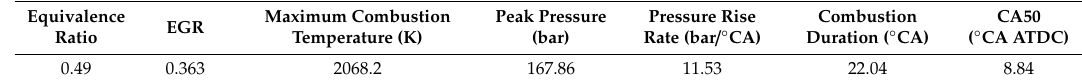
Figure 12. Optimizing process of fish swarm algorithm. Table 6. Optimized combustion parameter.